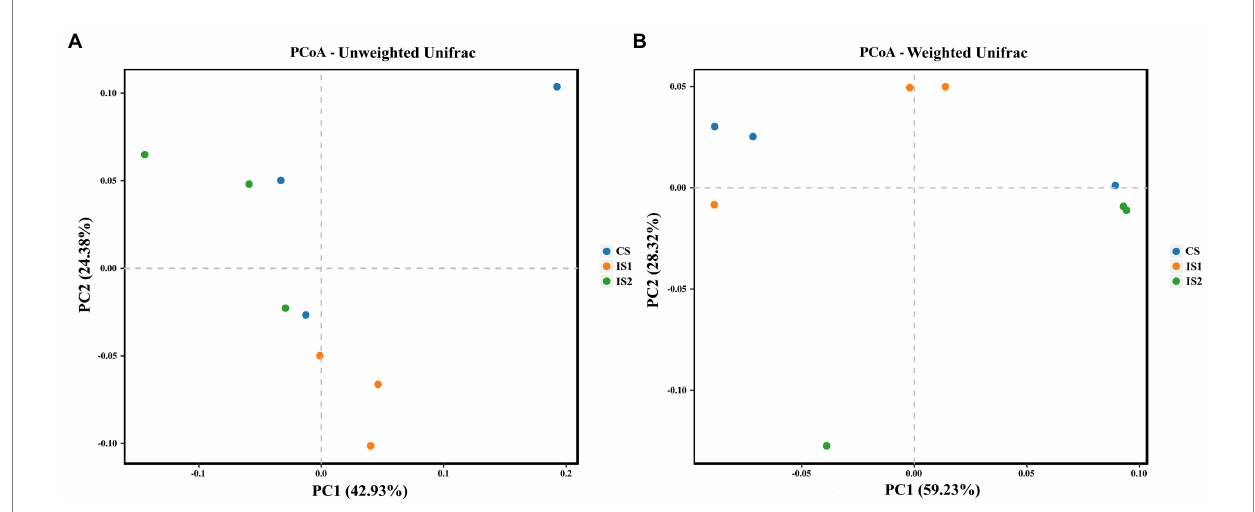
FIGURE 1 The principal coordinate analysis (PCoA) plots on the structure of the rumen bacterial populations across treatments. (A) PCoA based on the unweighted Unifrac matrix. (B) PCoA based on the weighted Unifrac matrix.